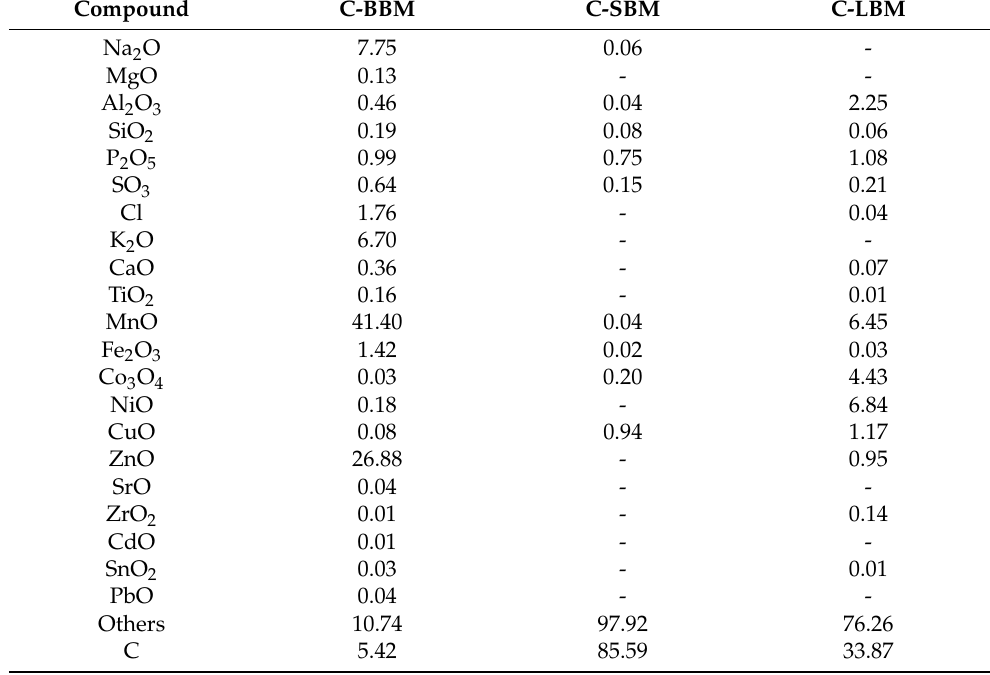
Table 2. Chemical composition (%wt) of the starting black masses. The carbon content appearing in the last row is that determined by combustion in an induction furnace and infrared